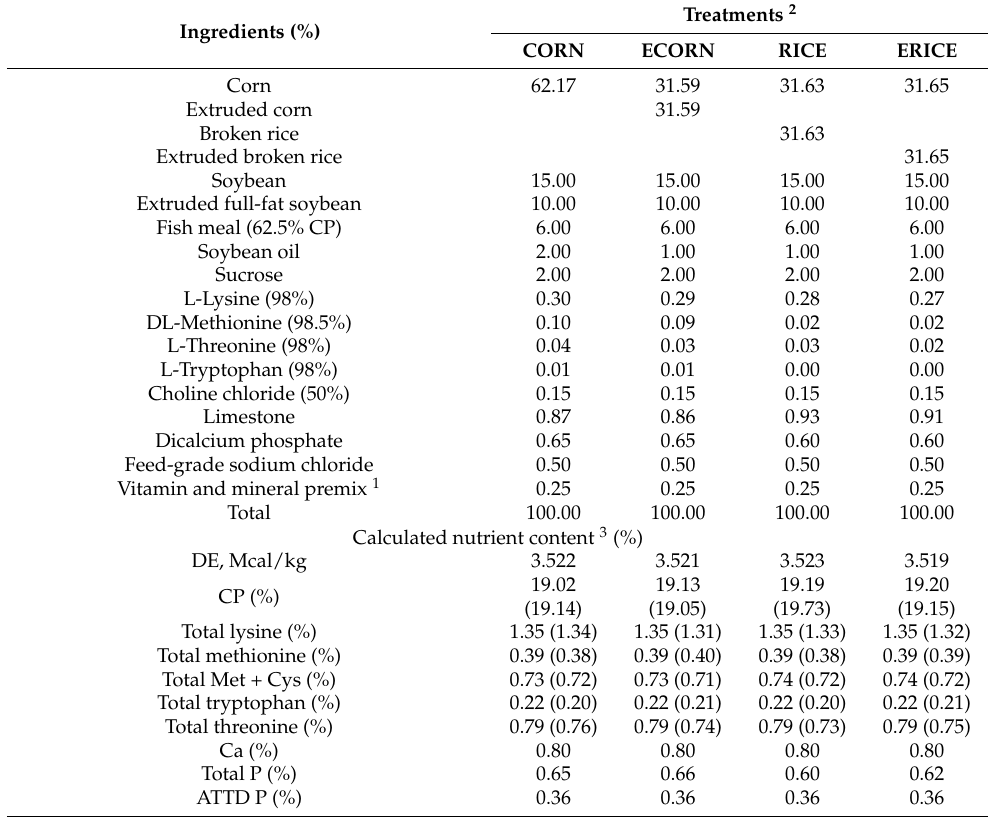
Table 1. Diet composition and nutrient content